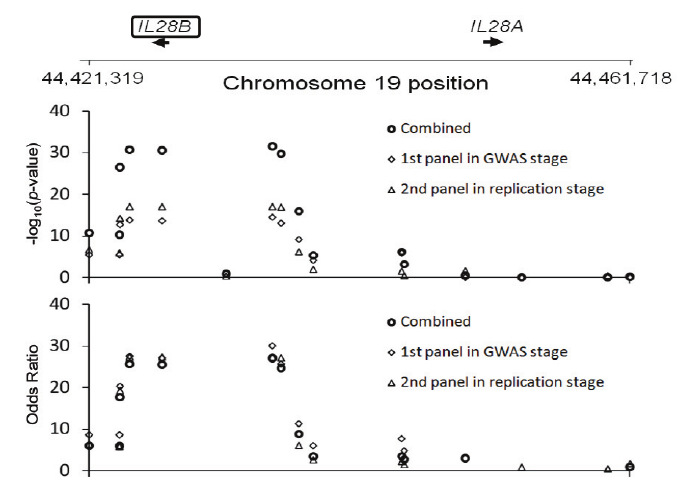
Figure 2. The strong association of IL28B with therapy response for chronic hepatitis C: 80% of non-responders possess the minor allele